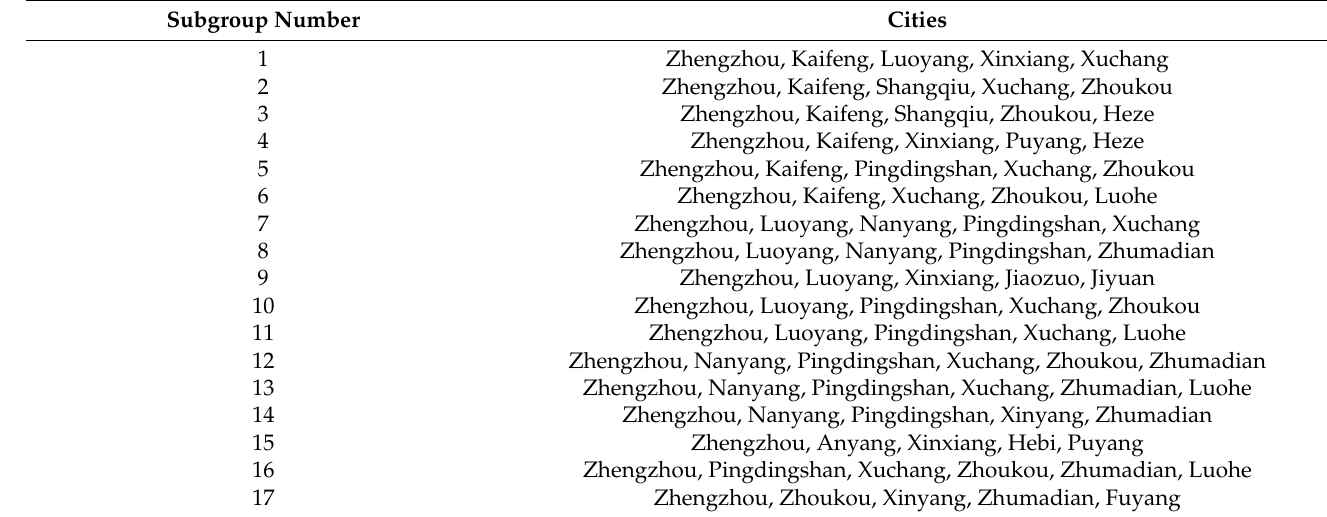
Table 2. Cohesive subgroups of Zhongyuan Urban